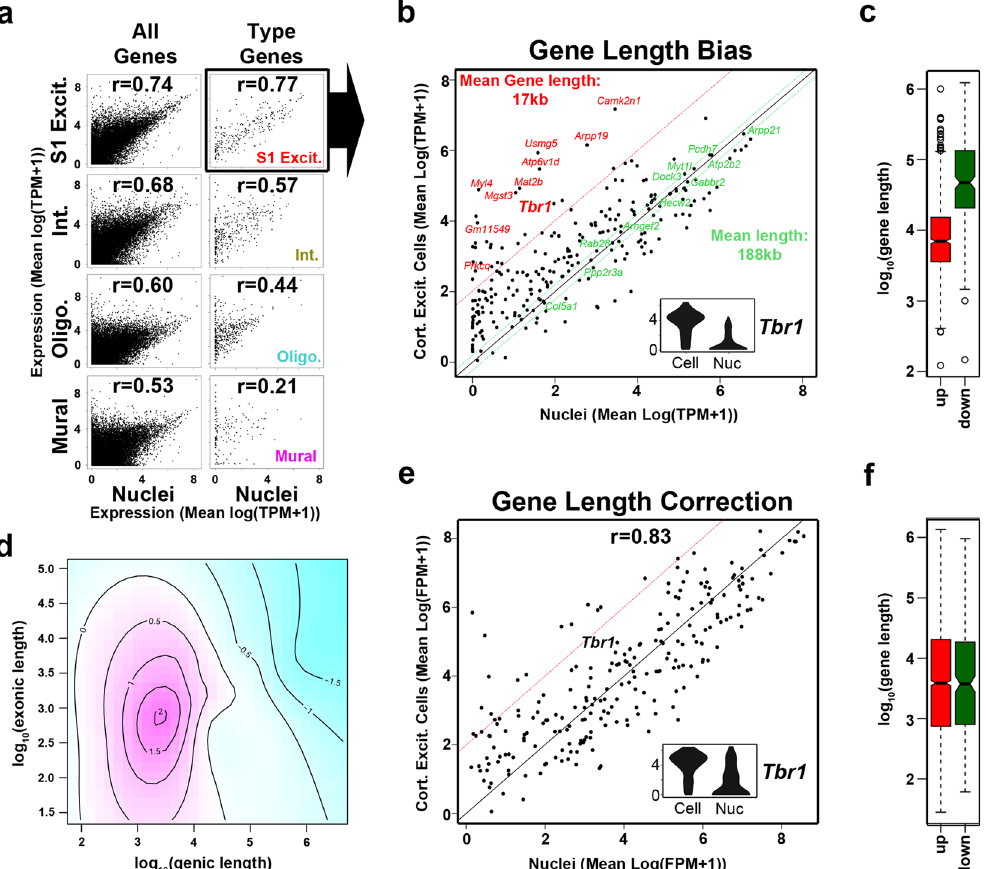
Figure 4. Gene length bias correction. ( a ) Scatter plots for nuclear and indicated cellular clusters using either all detected genes or the associated cell-type specific gene sets. Pearson correlation coefficients (r) are indicated. ( b ) Scatter plot indicated in ( a ) with genes detected higher in cells (red) or detected similarly between cells and nuclei (green) indicated. Inset is a violin plot of Tbr1 expression. ( c ) Boxplot illustrating significant difference in average gene length between genes detected as up or down in cells over nuclei (Supplementary Fig. S4; Student t test, p = 6.41 × 10 − 51 ; Wilcoxon test, p = 3.77 × 10 − 60 ). ( d ) The systematic length bias in the whole cell – nucleus comparison was captured by the generalized additive model. The plot shows the interaction of total gene length (genic) and exonic length of a gene (pink – higher M values (log2 fold expression difference between whole cells and nuclei), blue – lower M values; the levels are labeled on the contours). ( e ) Scatter plot as shown in ( b ) after gene length correction showing improved Tbr1 detection in nuclear data. ( f ) Boxplot on corrected expression values showing the absence of gene length bias (Supplementary Fig. S4; Student t test, p = 0.852; Wilcoxon test, p =